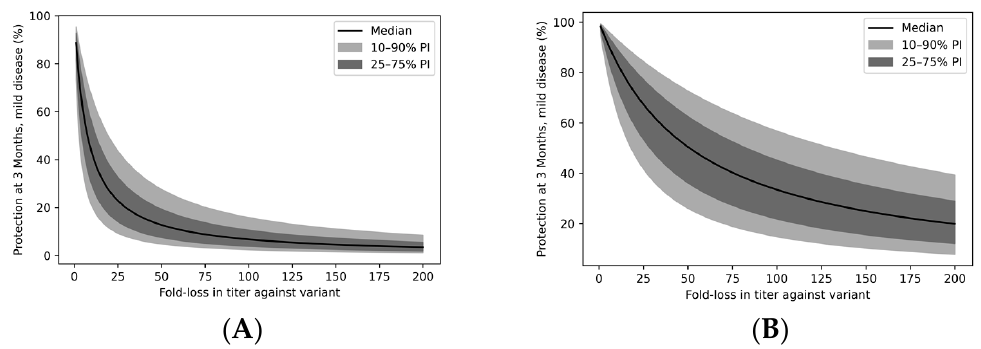
Figure 5. Protection from mild and severe disease at 3 months post-vaccination as a function of immune evasion. Percent protection from ( A ) . mild disease and ( B ) . severe disease. Immune evasion is expressed as the fold loss of vaccine serum titer against an immune-evading variant compared to WT pseudovirus.